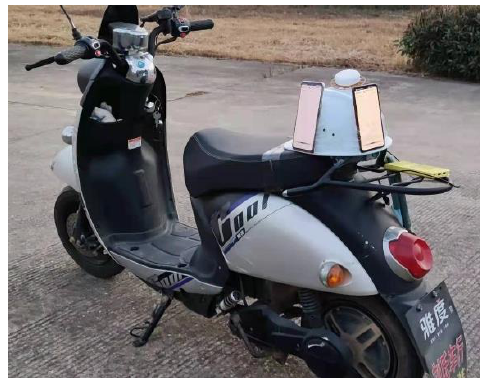
Figure 11. Experimental equiments.